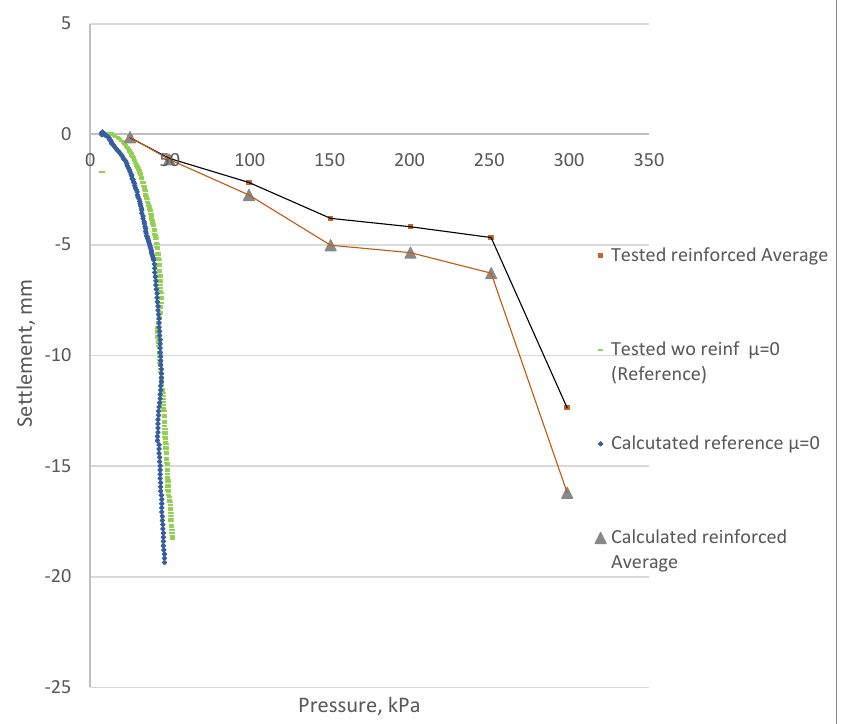
Figure 10. The averaged load – settlement curve for all tested samples compared with the averaged theoretical calculation results before and after the reinforcement process.